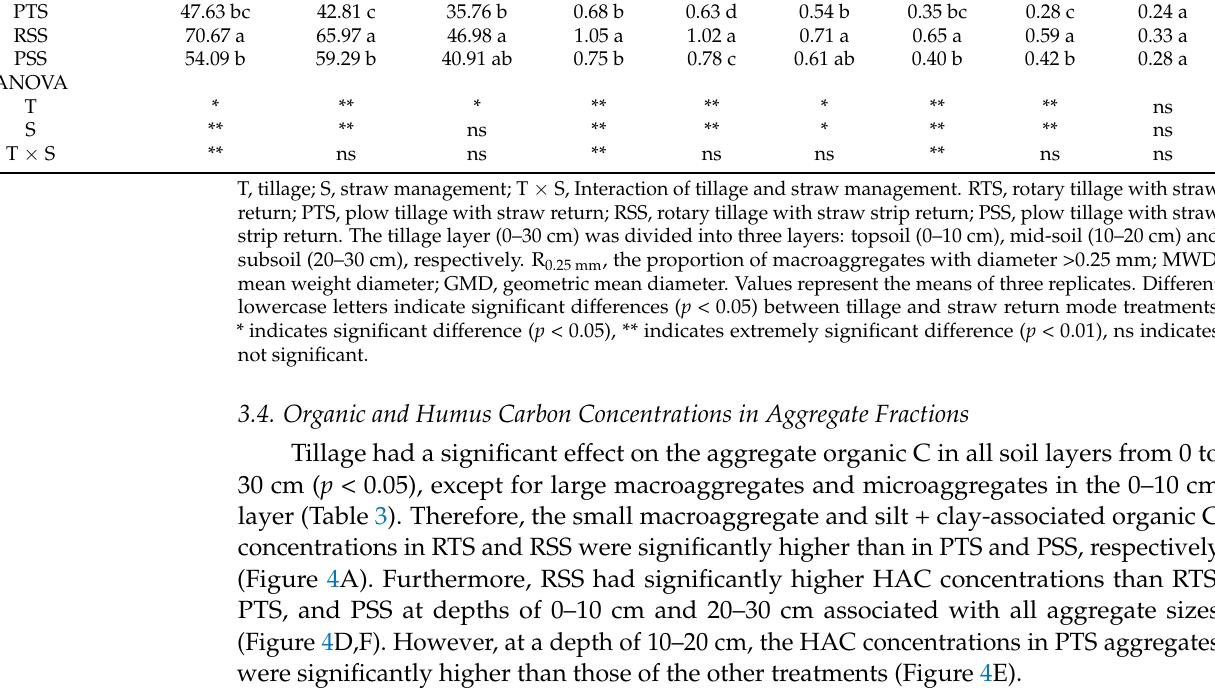
Table 2. Effect of tillage and straw return mode on the stability of soil water-stable aggregates. Straw Return